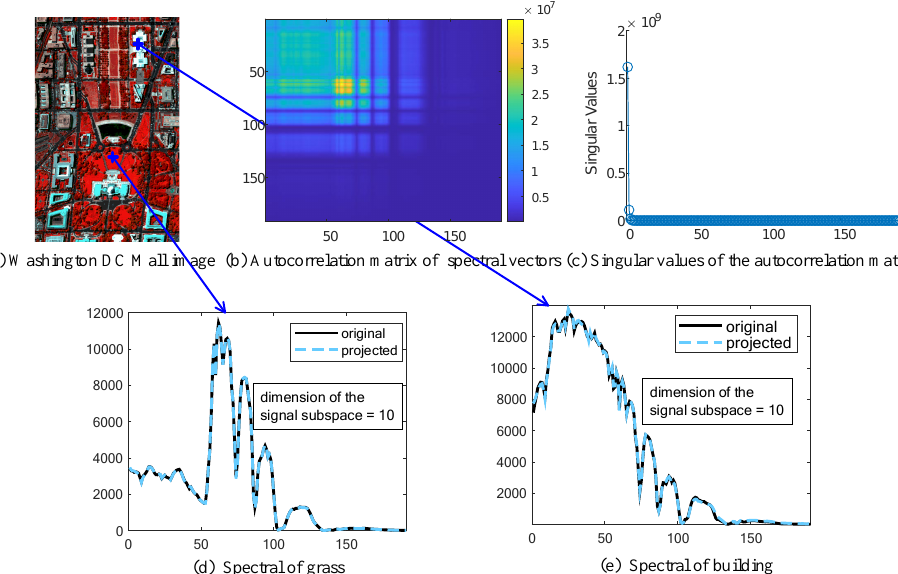
Figure 1. Subspace representation of spectral vectors in a subset of a Washington DC Mall image. Based on the subspace representation of spectral vectors, we write X = Z× + Ξ , (2) 3 E with E ∈ R n b × p ( p (cid:28) n b ), Z ∈ R r × c × p , and Ξ ∈ R r × c × n b . Matrix E holds an orthogonal basis for the signal subspace, and the entries of Z are representation coefficients of X with respect to E . Hereafter, mode-3 slices of Z are termed the eigenimages. Tensor Ξ represents residuals of a low-dimensional representation of X . When SVD is adopted, most of the image variation can be compactly represented in a low-dimensional subspace, and the residual tensor contains a small amount of image energy. Thus, we omit Ξ when reconstructing the image; that is, X = Z× 3 E . Figure 2 illustrates the subspace representation of a hyperspectral image. The observation model (1) can be written as Y = Z× + S + G . 3 E